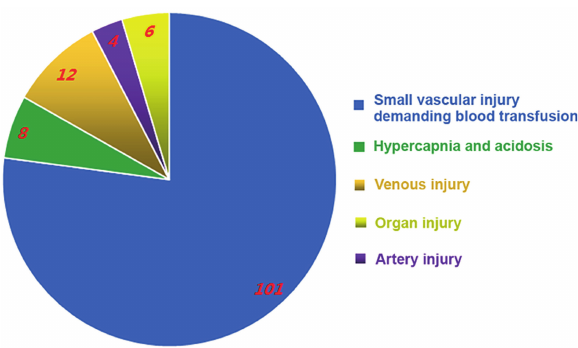
Figure 2 - The types of the intraoperative serious